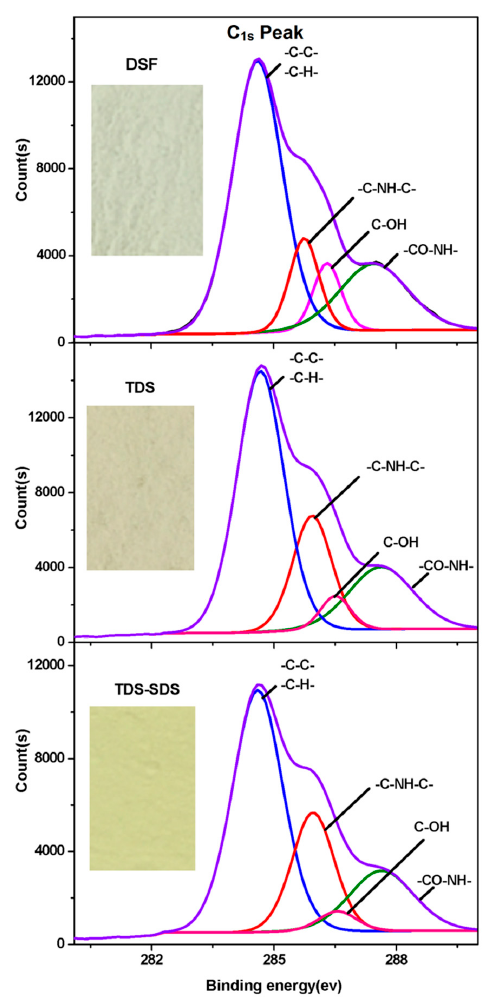
Figure 4. X-ray photoelectron spectroscopic (XPS) spectra and photographs of various DSF samples.